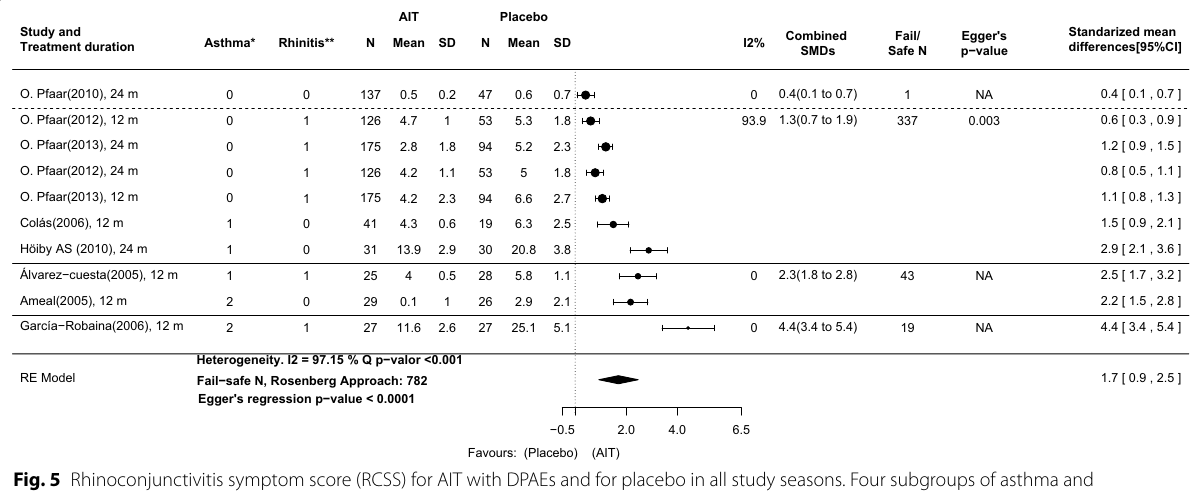
Fig. 5 Rhinoconjunctivitis symptom score (RCSS) for AIT with DPAEs and for placebo in all study seasons. Four subgroups of asthma and rhinoconjunctivitis severity are delimited by solid and dashed lines. *Asthma classification: (0) Only intermittent asthma patients included; (1) Intermittent to mild persistent asthma patients included; (2) Intermittent to moderate persistent asthma patients included. **Rhinoconjunctivitis classification: (0) Any rhinoconjunctivitis severity included; (1) Moderate to severe rhinoconjunctivitis included. 95%CI: 95% confidence interval; m months, RCSS rhinoconjunctivitis symptom score, SD standard deviation, SMDs standardized mean differences